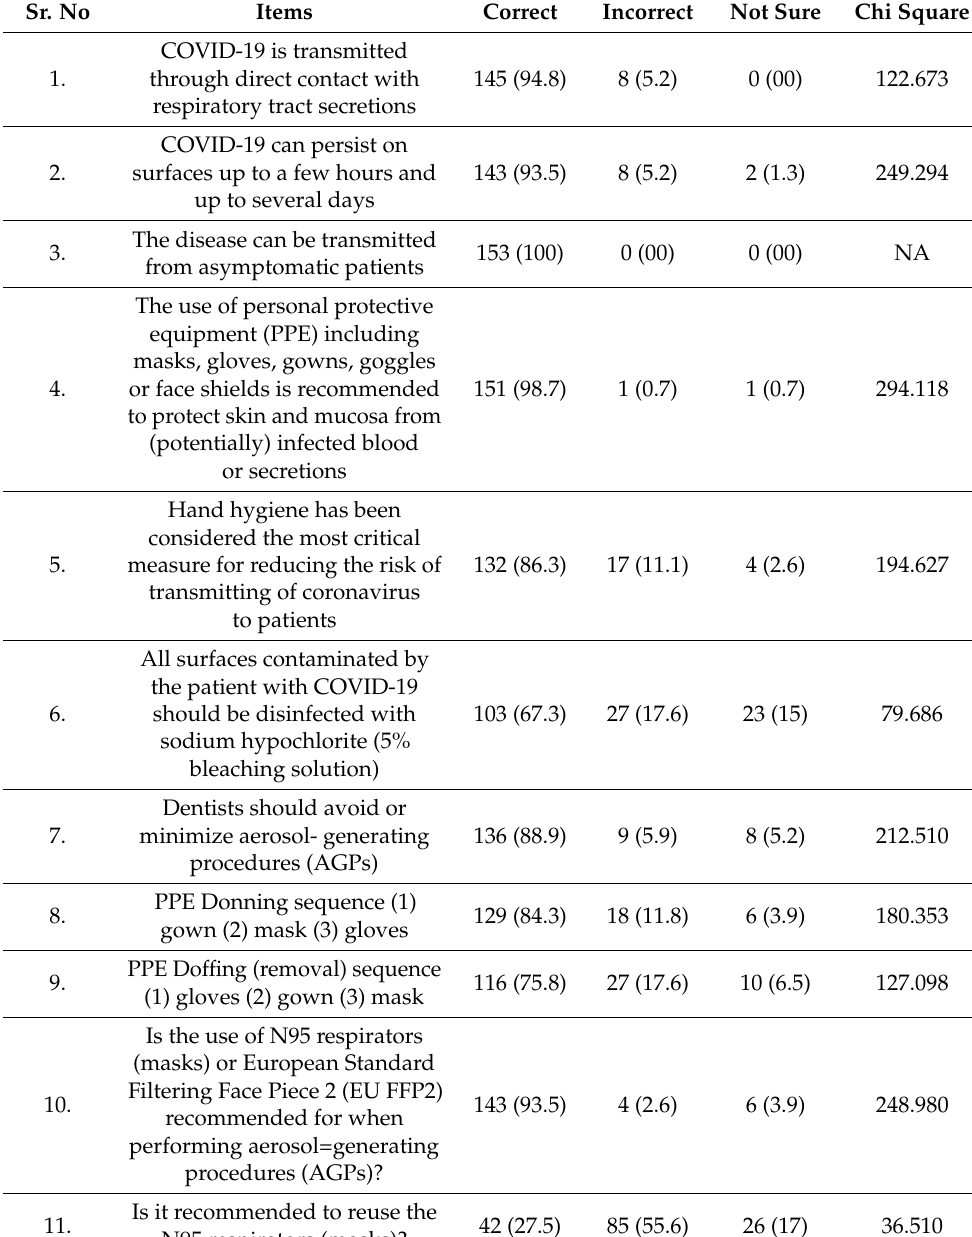
Table 1. Dentists’ knowledge about